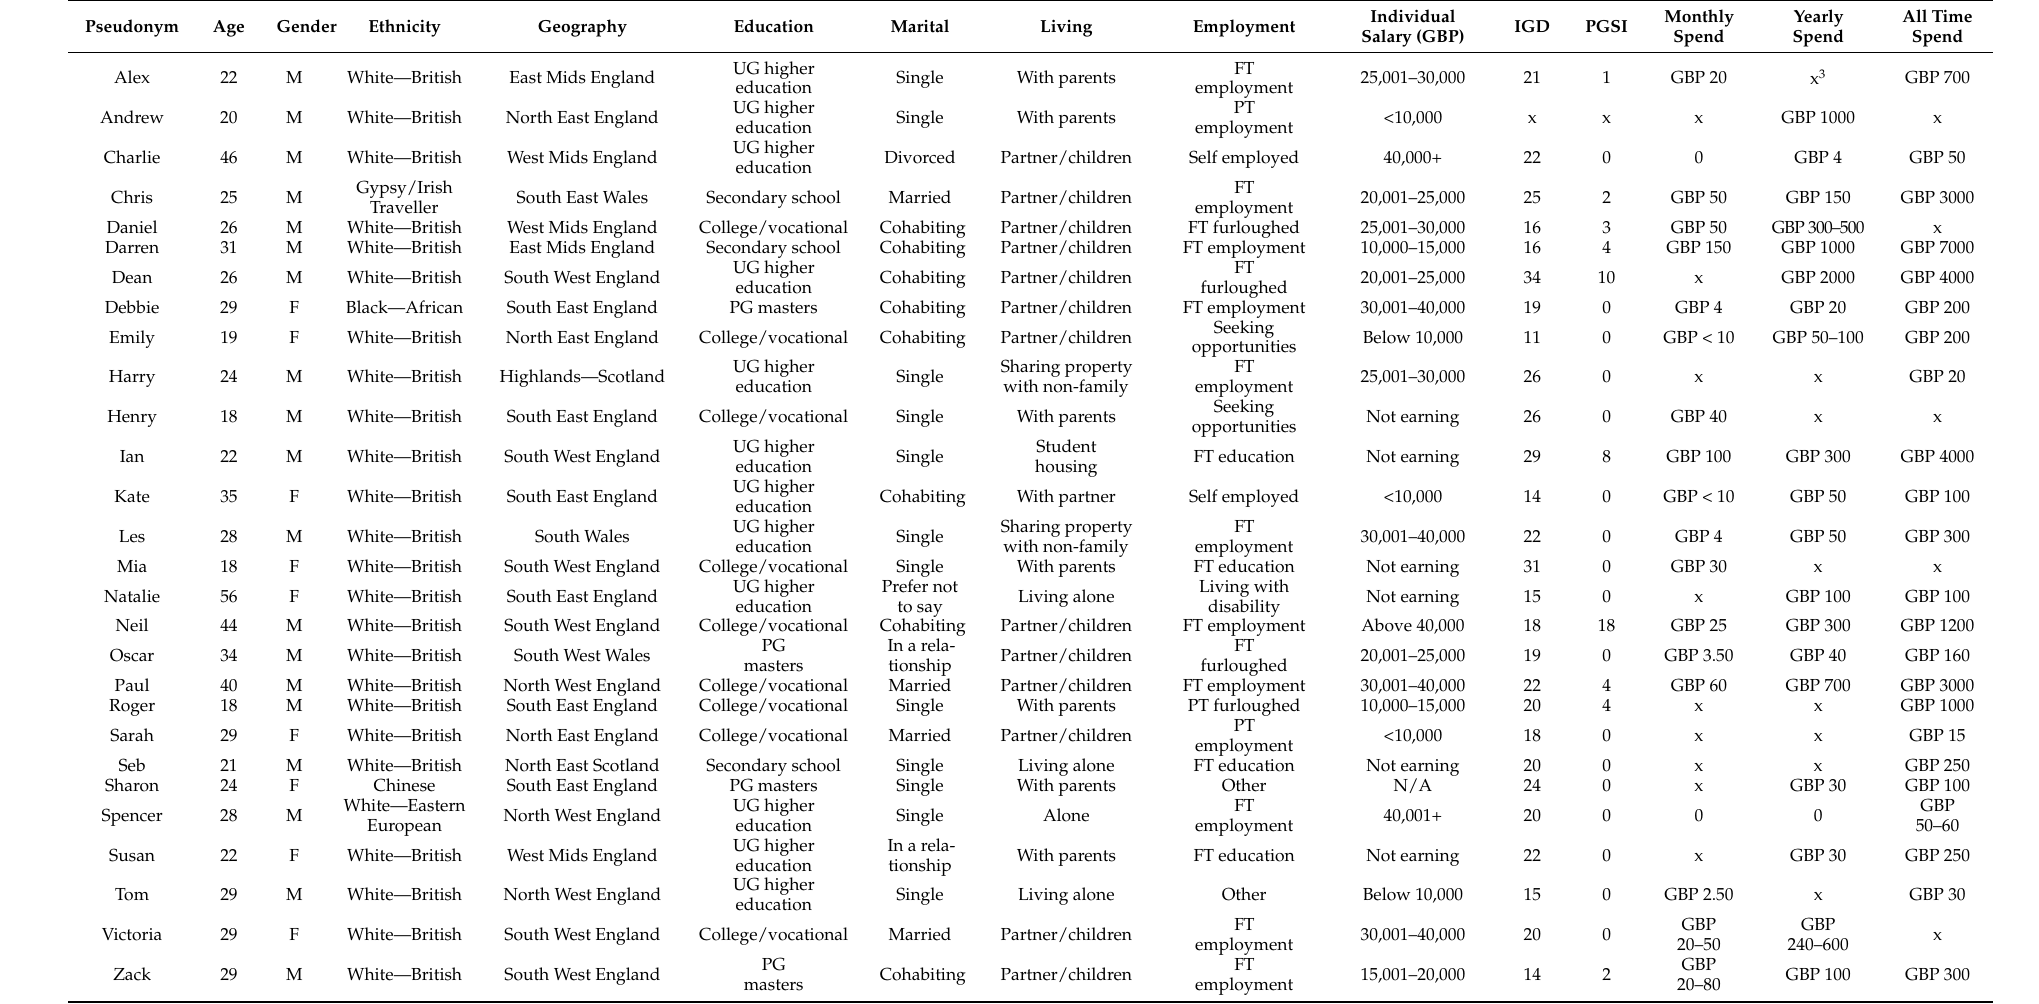
Table 1. Sample characteristics: demographics, gaming and gambling symptom scores, and loot box